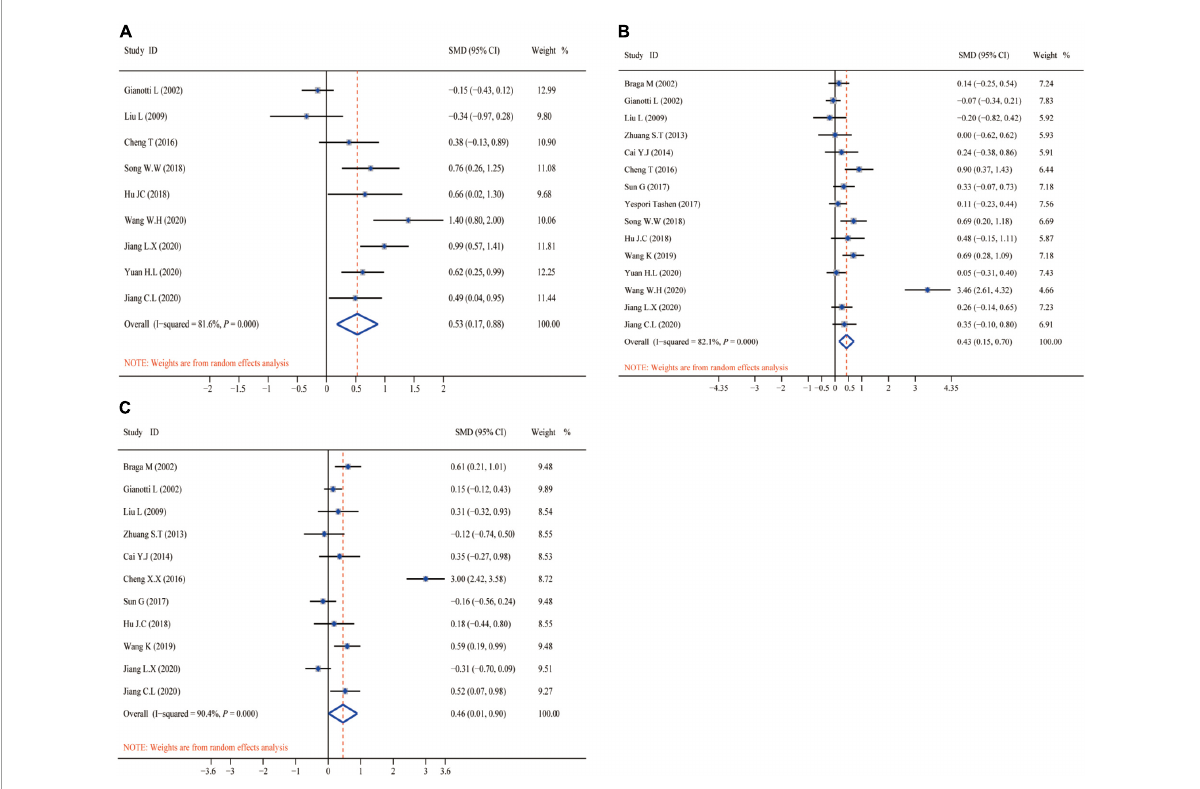
FIGURE6 Forest plot and SMD presentation for TP, ALB, and PA. (A) Forest plot of TP; (B) forest plot of ALB; and (C) forest plot of PA. All aggregated analyses were used random-effect model. TP, total protein; ALB, albumin; PA,